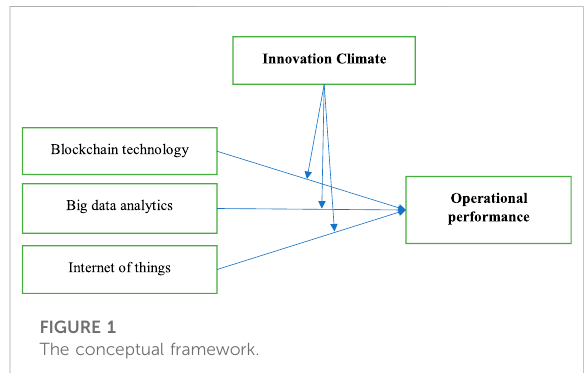
FIGURE 1 The conceptual